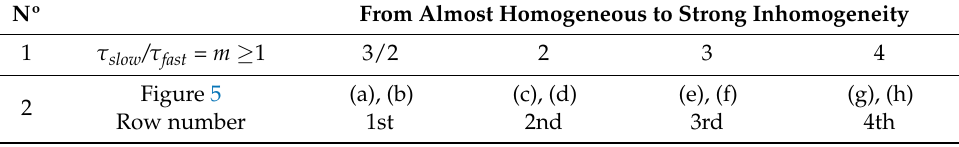
Table A1. The values for the parameters for m = 3/2, 2, 3 and 4 in Figure 5. From Almost Homogeneous to Strong